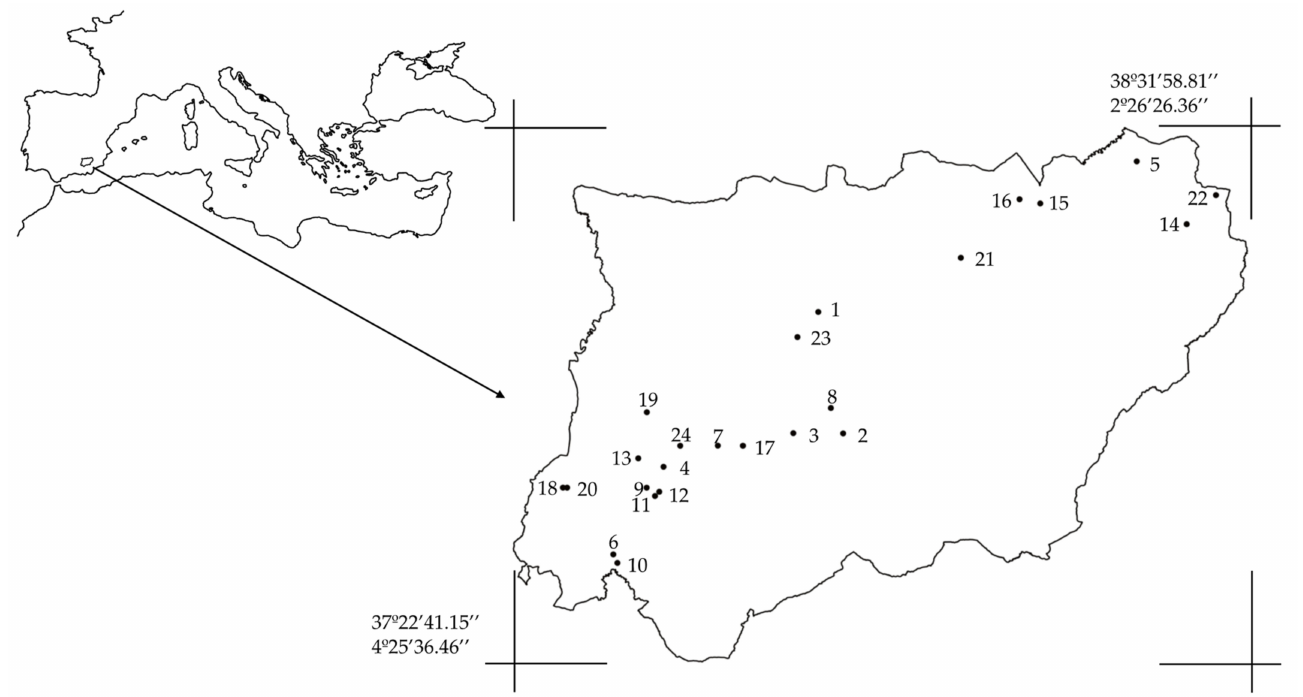
Figure 1. Location of studied wetlands. Wetland’s code: 1. Ardal; 2. Argamasilla; 3.